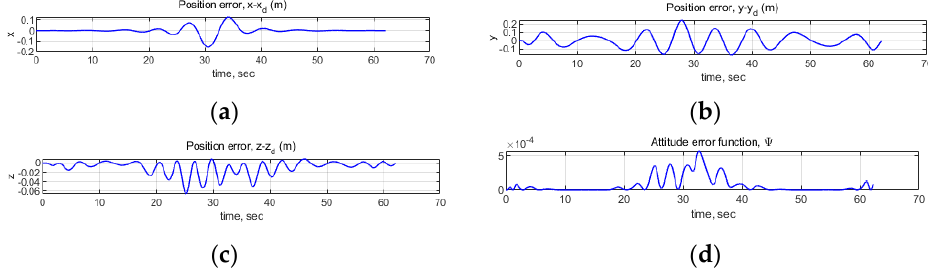
Figure 13. Quantitative analysis of error value in trajectory tracking: ( a ) position error of UAV in the x-direction; ( b ) position error of UAV in the y-direction; ( c ) position error of UAV in the z-direction; ( d ) error value of UAV yaw angle.